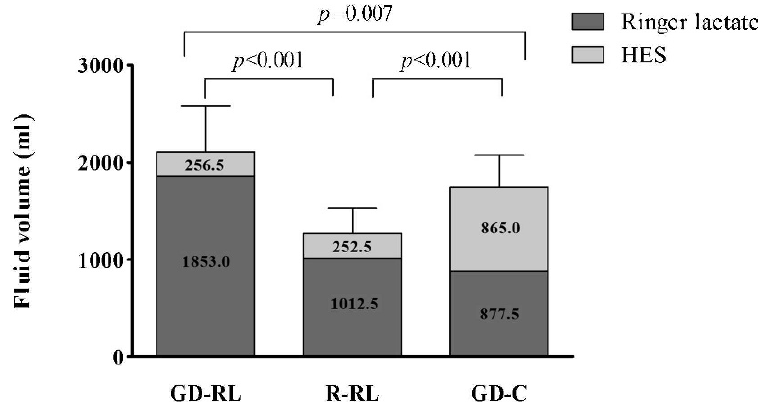
Figure 1 - Intraoperative fluid infusion